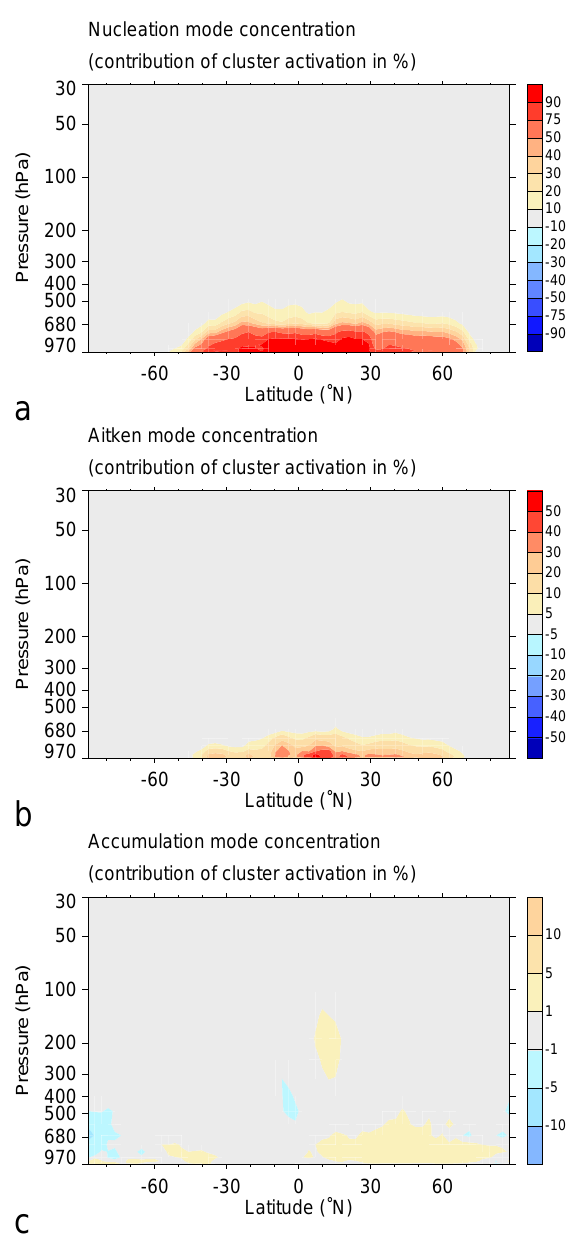
Fig. 9. Contribution of cluster activation in simulation S ref to the annual and zonal mean concentration of (a) nucleation, (b) Aitken, and (c) accumulation mode particles. The contribution to coarse mode particles (not shown) is very small.